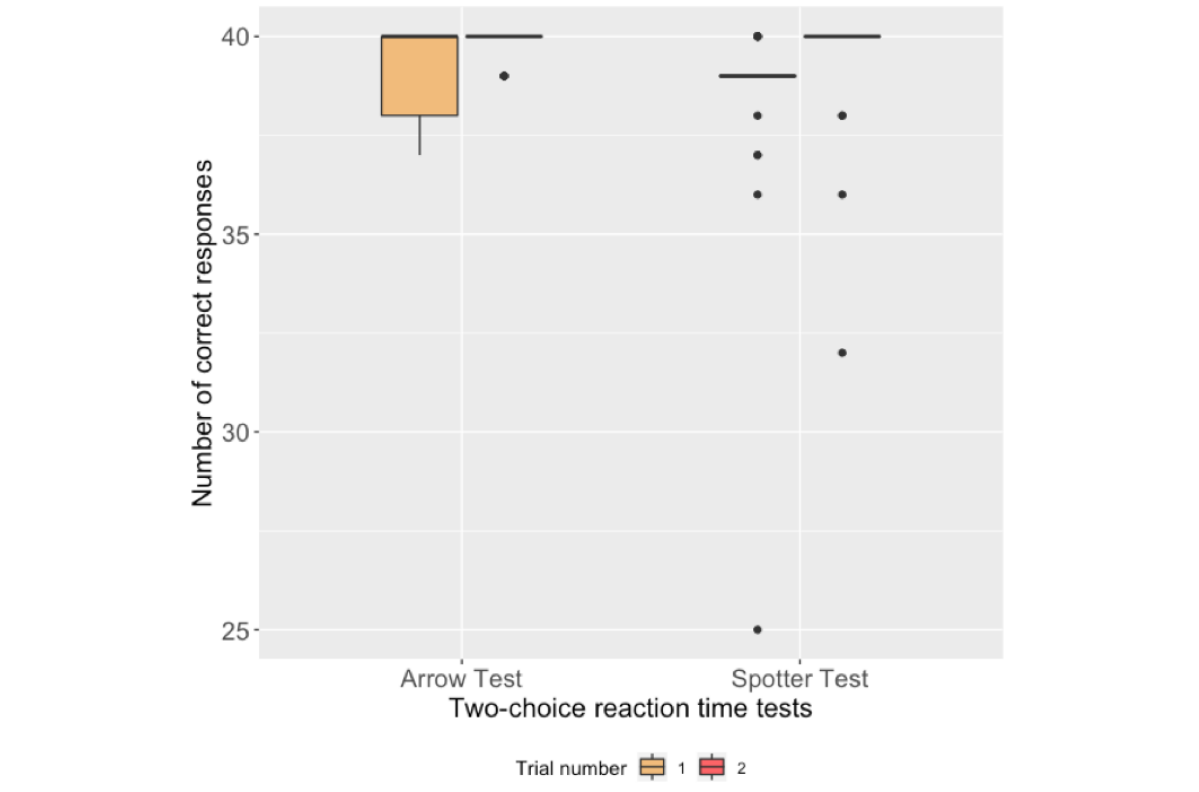
Figure 6. Box plots of participants’number of correct responses during the two-choice reaction-time tests.